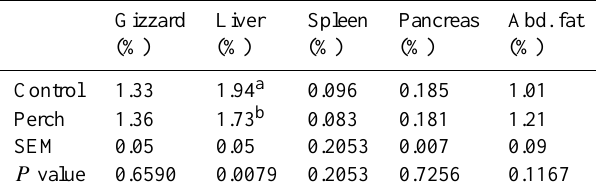
Table 5. Effects of perch availability on weight (percent of live body weight) of some internal organs and abdominal fat of